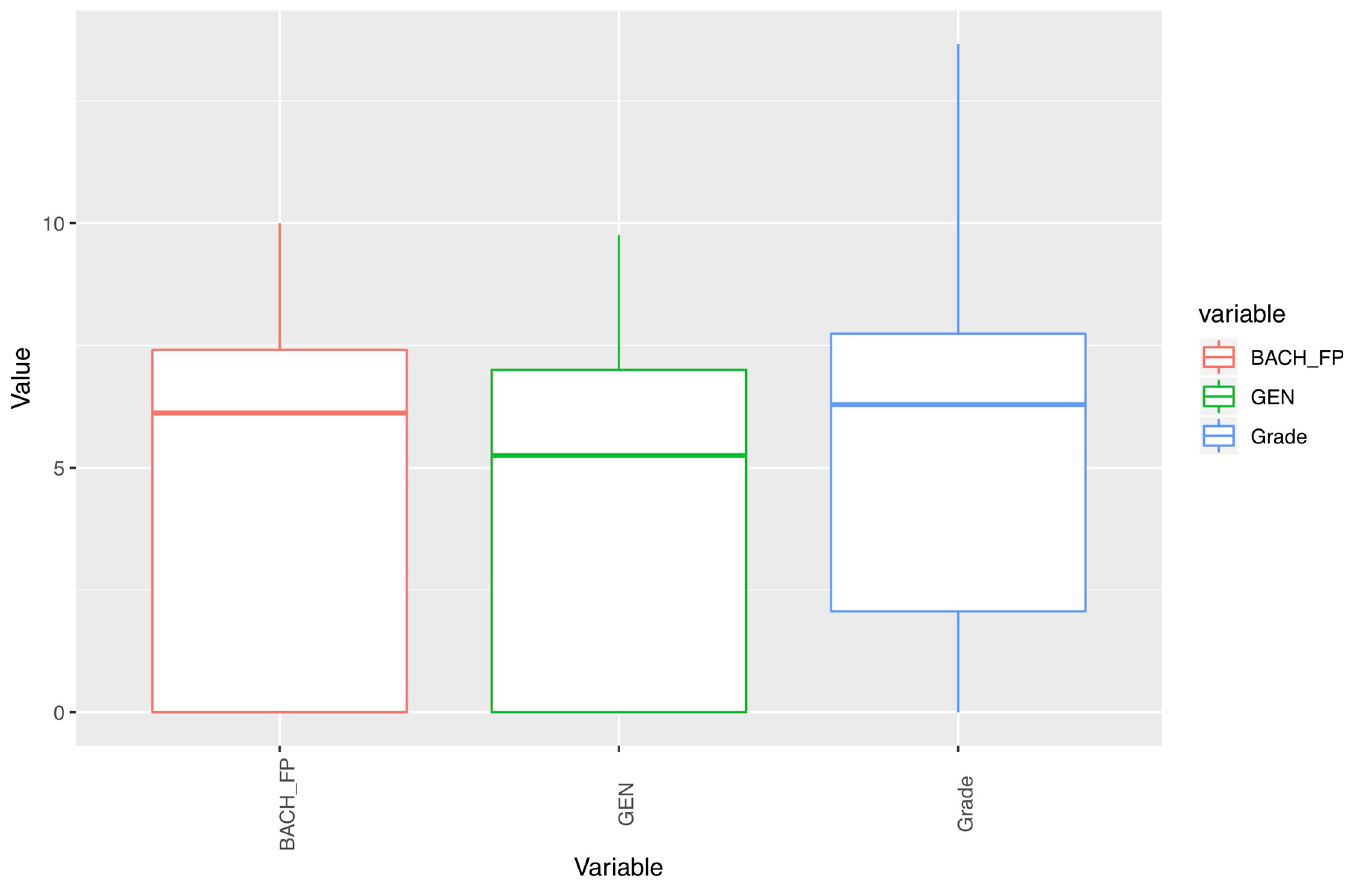
Fig 5. Box-plots for variables concerning academic records.